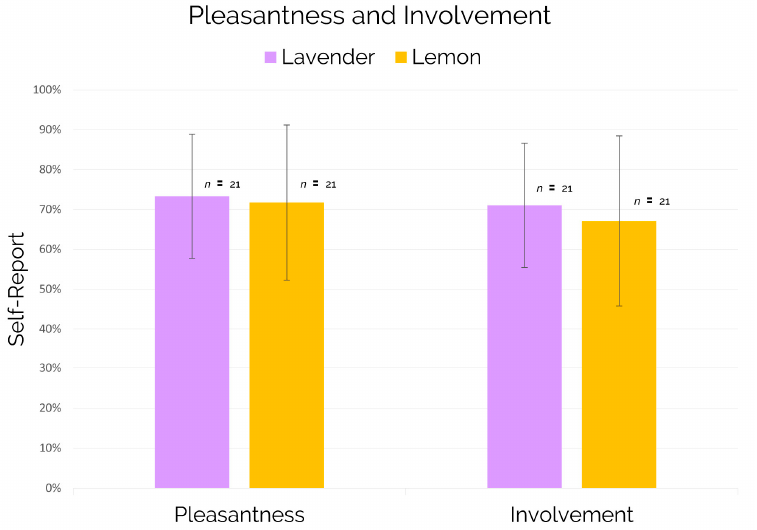
Figure 10. Self-reported measures of pleasantness and involvement associated to the entire virtual reality experience and provided by subjects at the end of the experimental session.